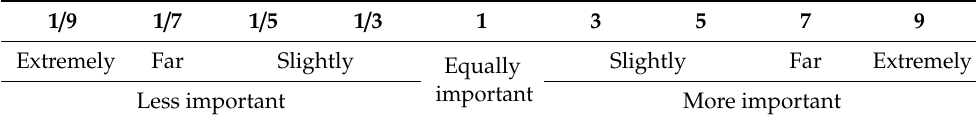
Table 2. Saaty scale for pairwise comparison between the criteria in the AHP.